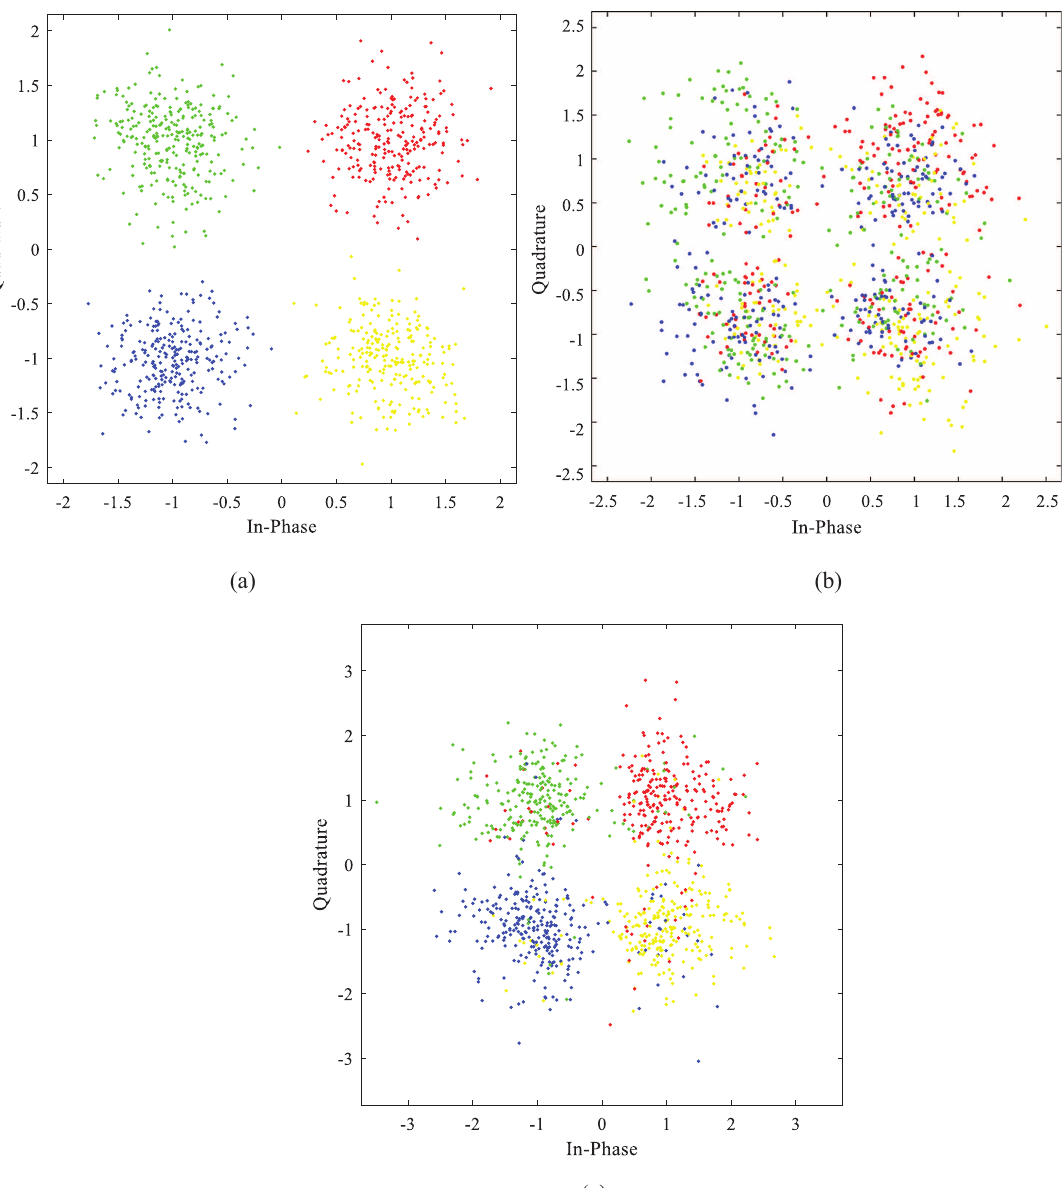
Figure 9. Comparison of constellation diagrams generated by QPSK modulation, CSI-QPSK modulation and demodulation: (a) Constellation diagram of QPSK modulation; (b) Constellation diagram of CSI-QPSK modulation; (c) Constellation diagram demodulated by